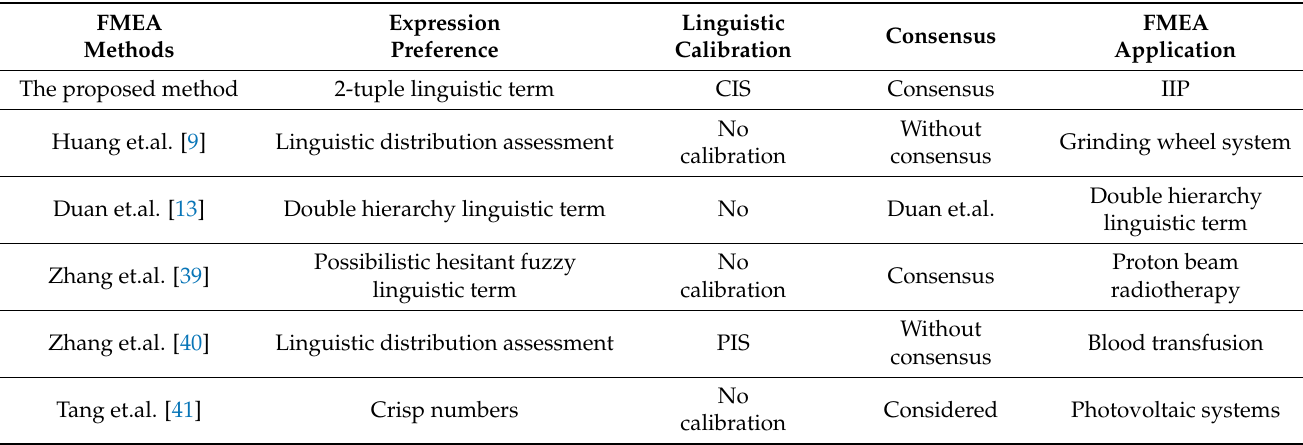
Table 10. Comparisons with related FMEA